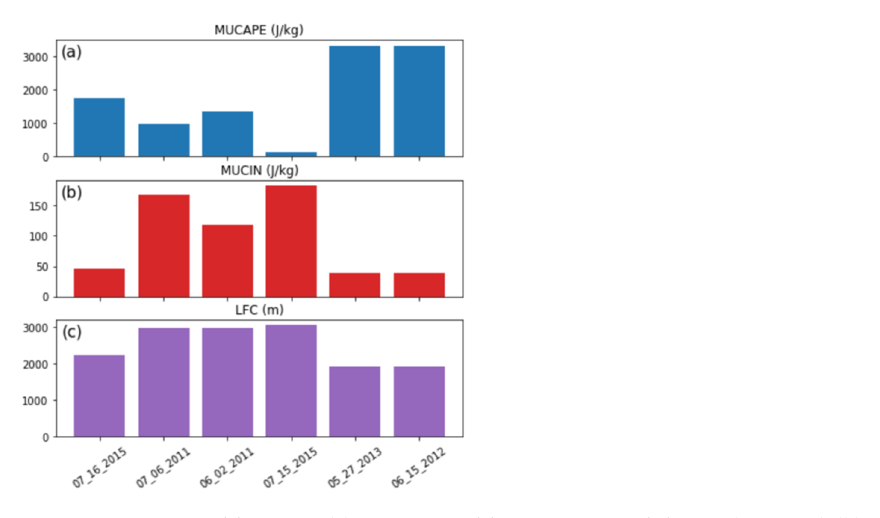
Figure 7. Most unstable CAPE ( a ), most unstable convective inhibition (MUCIN) ( b ), and level of free convection (LFC) height ( c ) within the inflow region for the same set of cases as in Figure 6, with top row of Figure 6 represented by the leftmost three dates, and bottom row represented by the rightmost three dates.